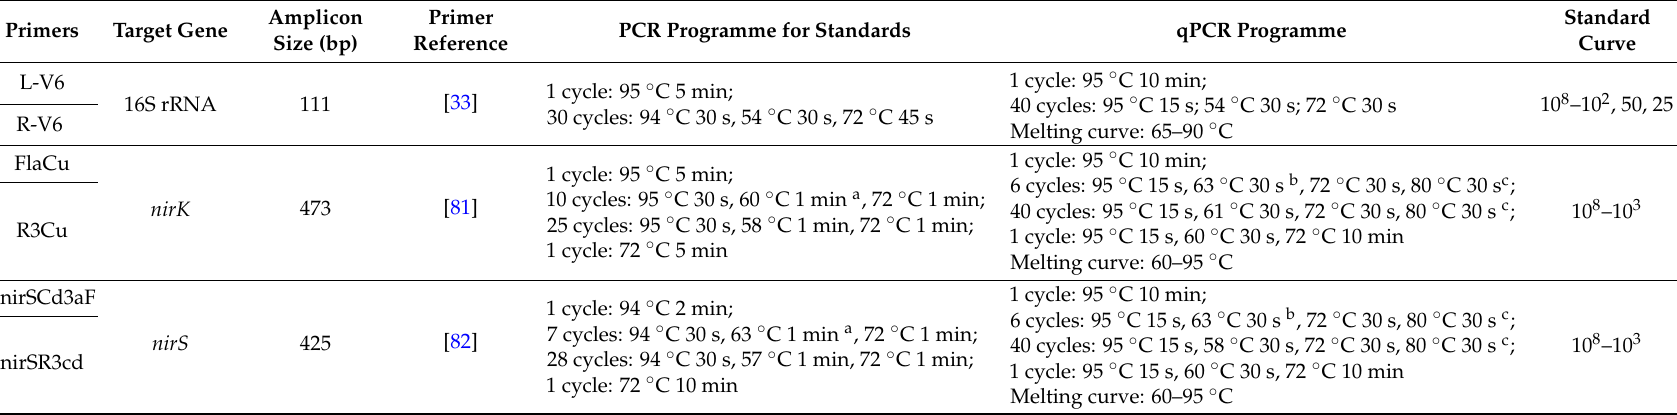
Table A1. Characteristics of primer sets and amplification programmes used. Standard curve marks the range of standard dilutions (gene copies in 10 µ L of reaction mixture) used for creating standard